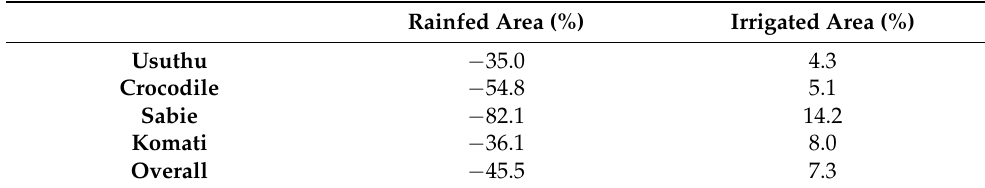
Table 3. Percentage change per sub-catchment in agricultural systems between 2019 and